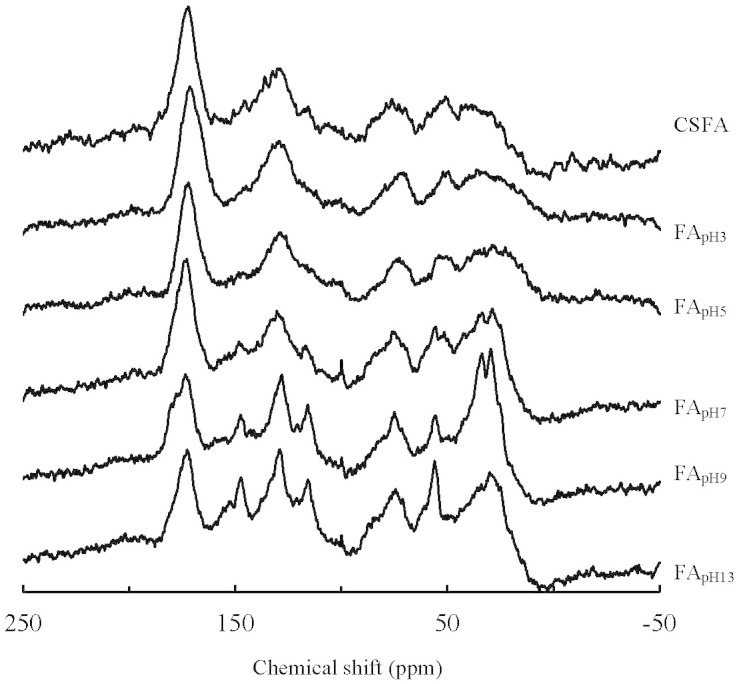
13C-NMR spectra of CSFA and its sub-fractions.